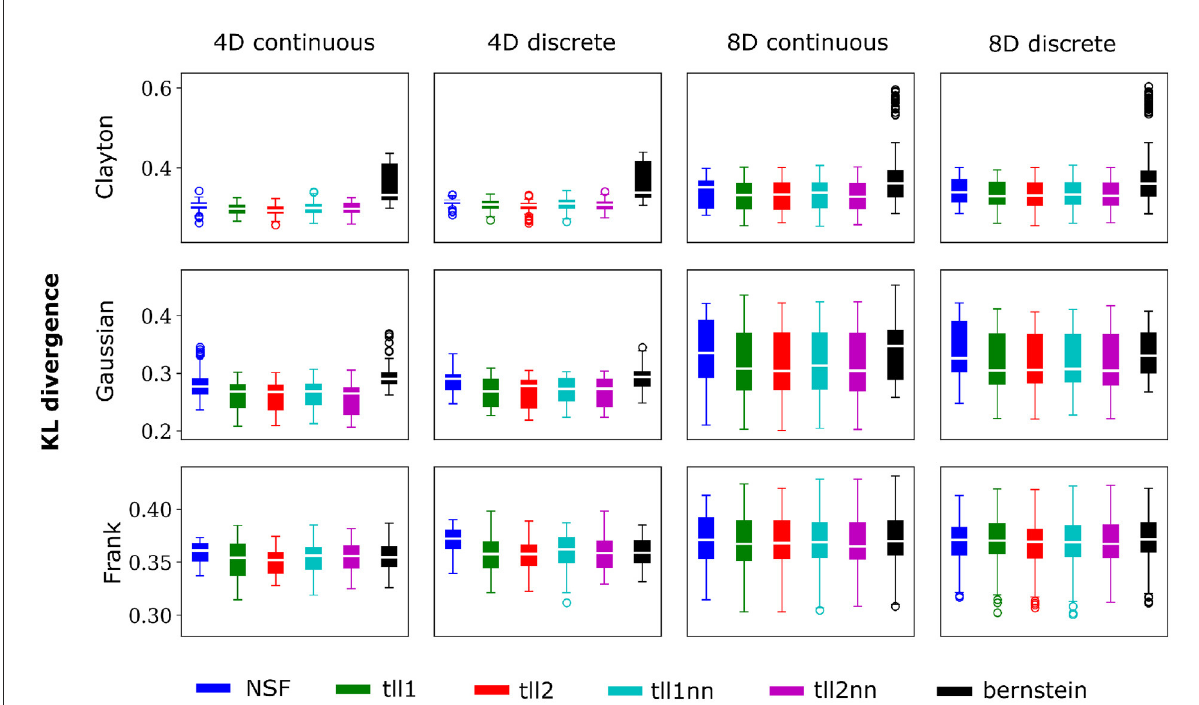
FIGURE2 NSFs perform comparably to existing non-parametric estimators. Boxplots of performance of NSFs on all bivariate copulas from artificial data compared to Kernel Density Estimators with either log-linear local likelihood estimation (tll1), log-quadratic local likelihood estimation (tll2), log-linear local likelihood estimation and nearest neighbor bandwidths (tll1nn), log-quadratic local likelihood estimation and nearest neighbor bandwidths (tll2nn), and Bernstein estimator. Simulations shown in this figure had weak dependencies described by Clayton ( θ = 2), Gaussian (0.4 in the off-diagonal), and Frank copulas ( θ = 3) for four and eight dimensional vines with continuous and discrete